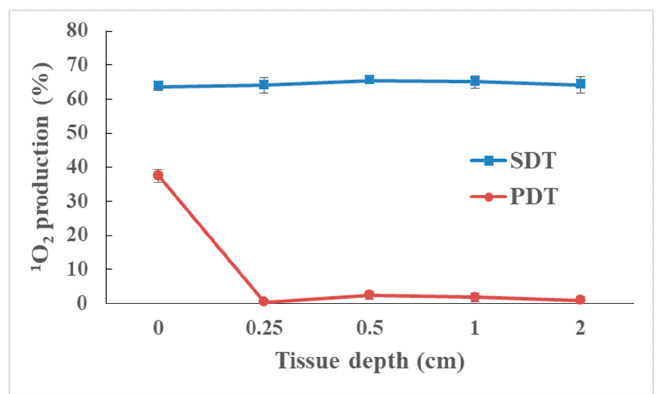
Figure 7. 1 O 2 production of Ce6-P/W NEs at different tissue depths when irradiated with ultrasound (0.25 W/cm 2 , 2.1 MHz, 1 min, SDT) or white light (60 lumens, 1 min, PDT). Ce6-P/W NE concentration, 400 μ g/mL. Ce6 concentration, 8 μ g/mL. Data were presented as mean value ± standard deviation. After Levene’s test for equality of variances, one-way analysis of variance (ANOVA) and Bonferroni multiple comparison test was employed for the comparison of mean values. n = 3. The control group receiving no light showed 1 O 2 production of (1.026 ± 0.939)%. 1 O 2 , singlet oxygen. Ce6-P/W NE, chlorin e6-perfluoropolyether (PFPE) / water nanoemulsion. SDT, sonodynamic therapy. PDT, photodynamic